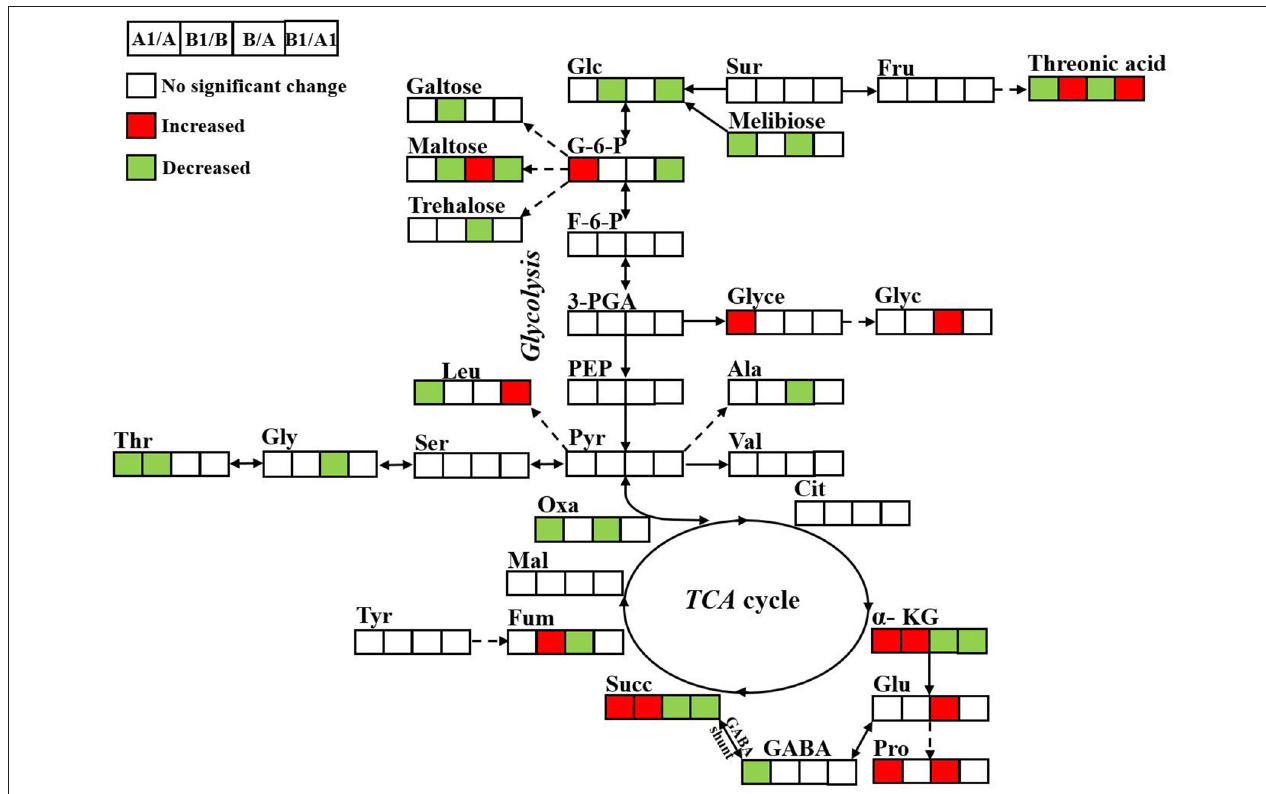
FIGURE 8 | Metabolic changes involved in the primary pathways of alfalfa roots under alkali treatment. The significantly up- and down-regulated (VIP > 1, P < 0.05) metabolites were indicated in red and green, respectively. NI alkali-treated/NI Control (A1/A); RI alkali-treated/RI Control (B1/B), RI Control/NI Control (B/A), RI alkali-treated/NI alkali-treated